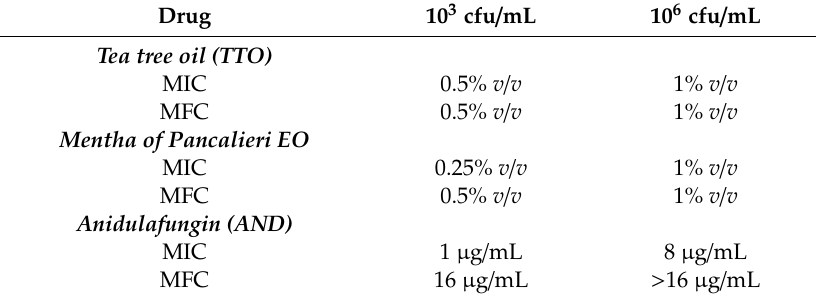
Table 1. Susceptibility of Candida krusei to tea tree Oil (TTO), “Mentha of Pancalieri” EO, anidulafungin (AND) expressed as Minimal Inhibitory Concentration (MIC) and Minimal Fungicidal Concentration (MFC). Drug 10 3 cfu / mL 10 6 cfu / mL Tea tree oil (TTO) MIC